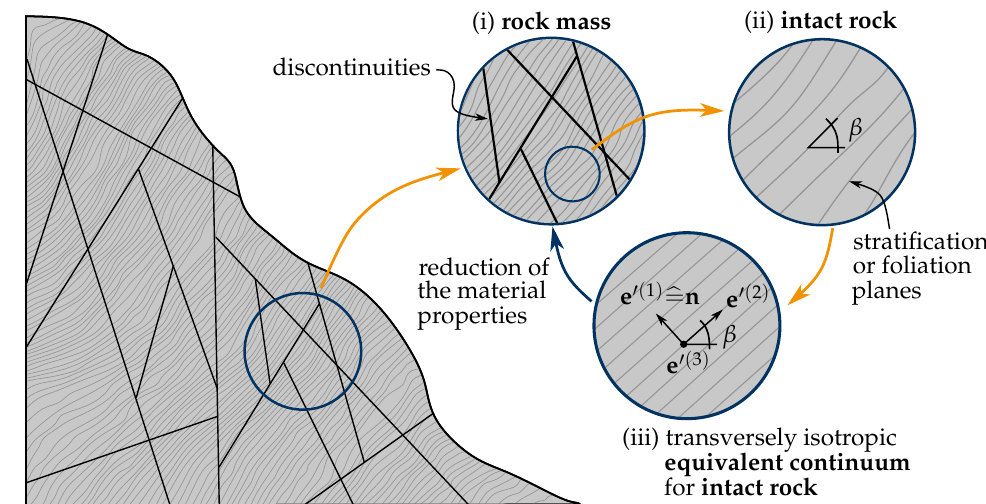
Figure 2. Schematic sketch of (i) the discontinuities in rock mass, (ii) the stratification or foliation planes in intact rock and its consideration in the TI-RDP model by (iii) the transversely isotropic equivalent continuum for stratified or foliated intact rock.